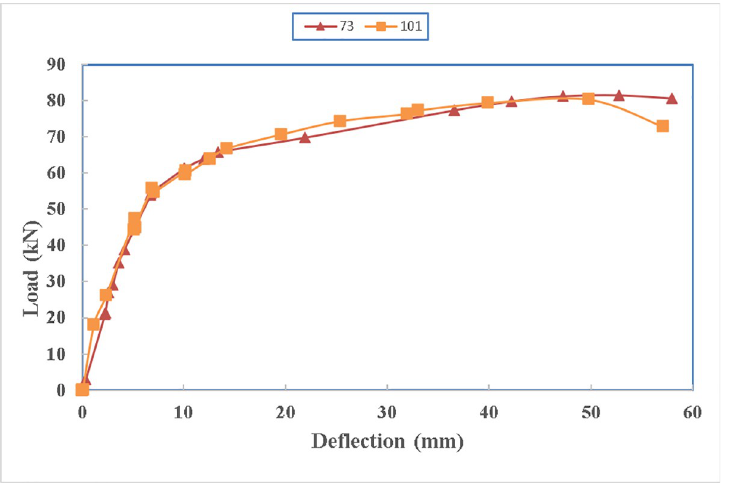
Fig 29. Load- deflection diagram between beam 73 and beam